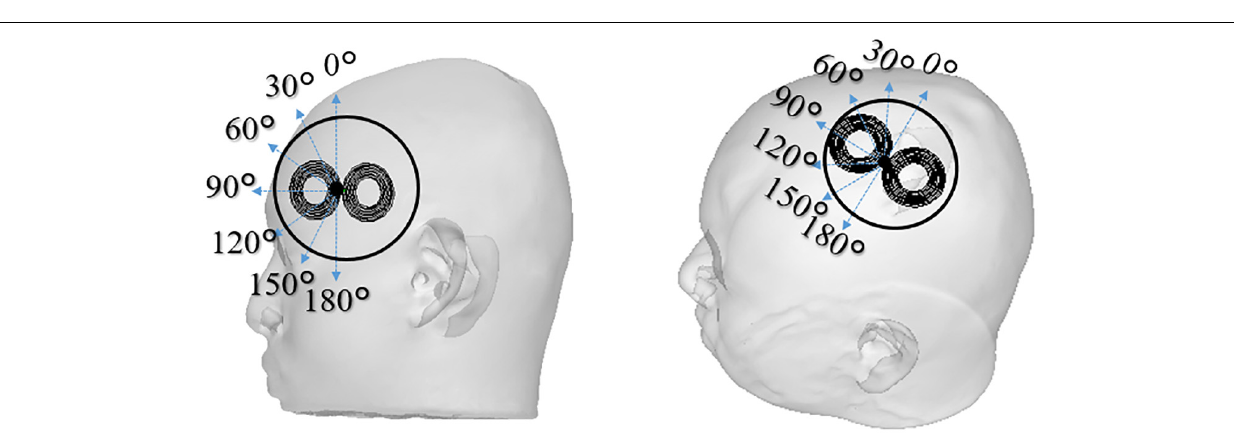
FIGURE 2 | The TMS coil is placed in different coil orientations relative to the subject’s scalp used in the experiments (0 ◦ –180 ◦ with steps of 30 ◦ ). Two scalp sites were investigated that corresponds to stimulation of Broca’s area and M1 of the left hemisphere. The reference coil orientations for 0 ◦ were defined as the inferior-superior orientation for the Broca’s area, and 45 ◦ inward relative to the anterior-posterior orientation for the M1. The orientation and positions are recorded to be used in the individualized dosimetry computation